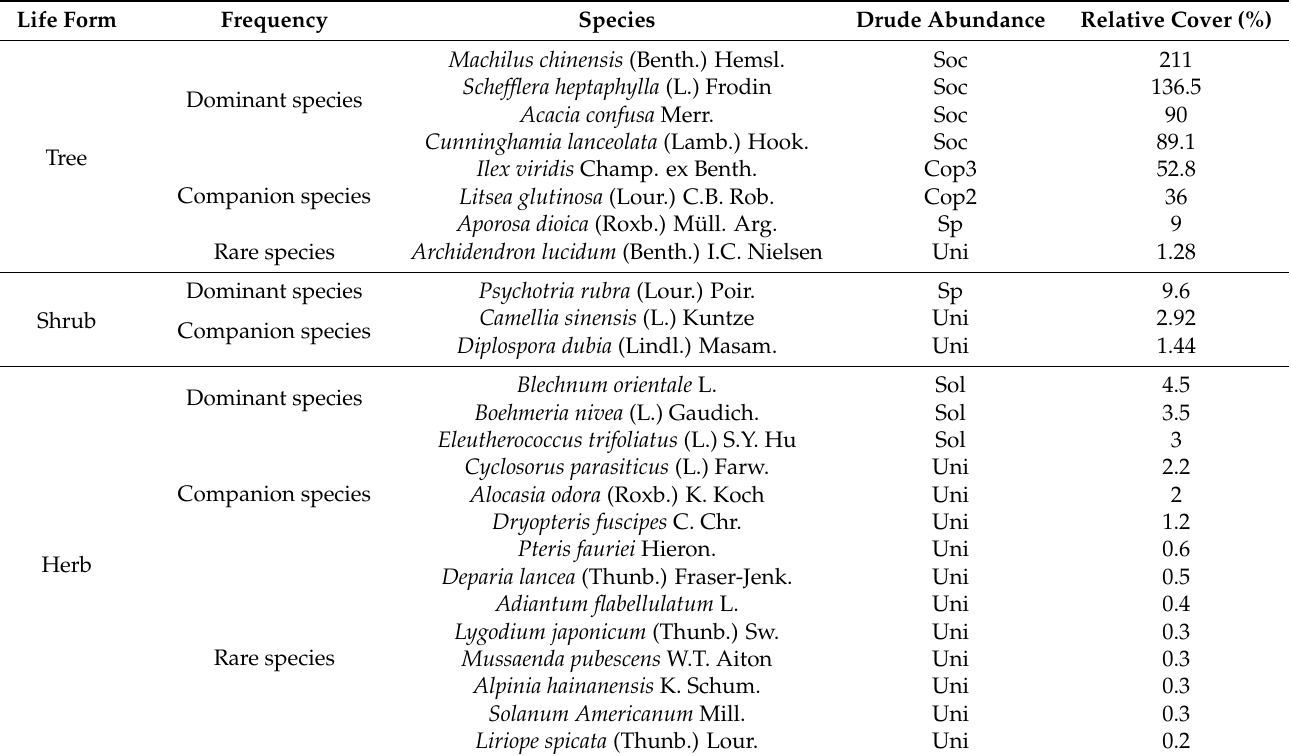
Table 3. All species recorded in quadrats established around adult individuals of Sphaeropteris lepifera on Nan’ao Island. Life Form Frequency